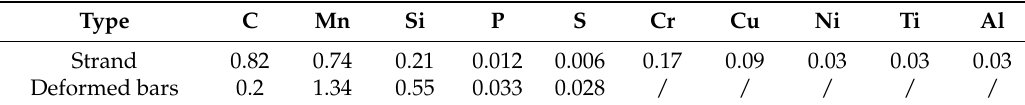
Table 2. Chemical compositions (wt %) of steel [28].